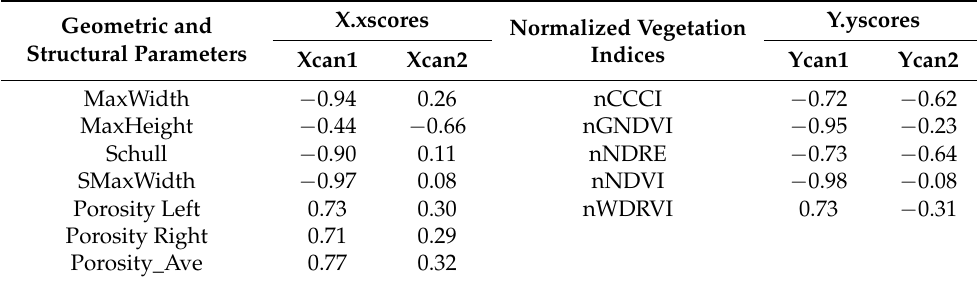
Table 5. Correlation between scores of the canonical variables (Xcan1 and Ycan1) and the correspond- ing scores of the original variables (structural and geometric orchard parameters, and the normalized vegetation